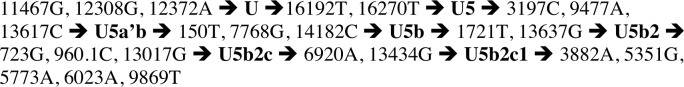
Key variable sites from rCRS found in the young man from Byrsa, with the marker path of mutations defining Haplogroup U to U5b2c1.Note, the mutation 16192T was not present in our sample.